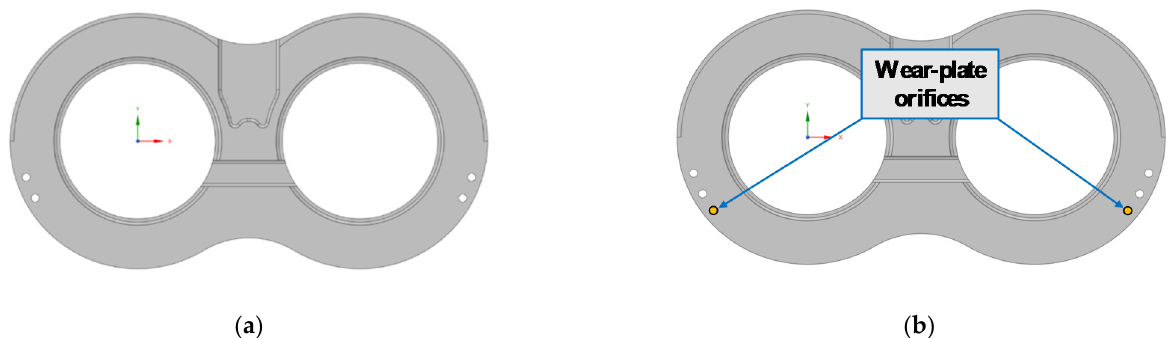
Figure 14. Wear-plate design: ( a ) Standard configuration; ( b ) Configuration with orifice connection to the ACV.